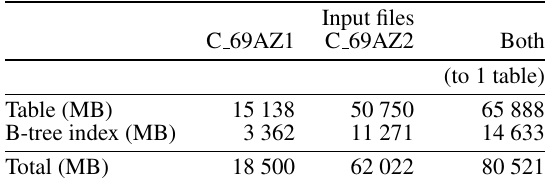
Table 1. Size of AHN3 input files. As reference also the time to convert the .laz file to ASCII text representation (with some attributes per point) is given.